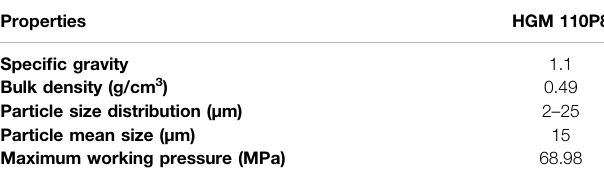
TABLE 2 | Speci fi cation of HGM 110P8 powder.